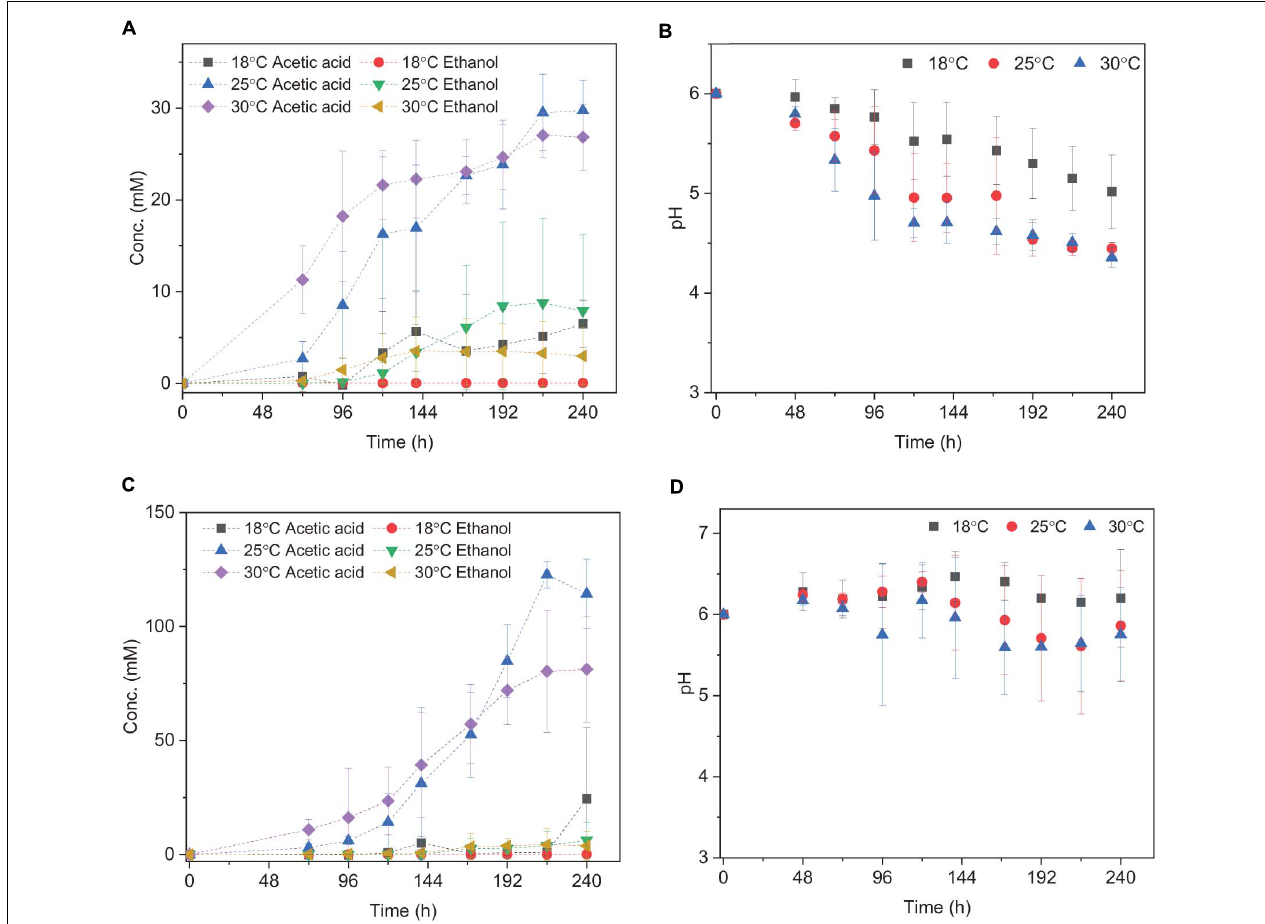
FIGURE 2 | Acetic acid and ethanol yield and pH change using (A,B) H 2 /CO 2 ; (C,D) H 2 /CO 2 + HCO 3 − by heat-treated granular sludge at 18, 25, and 30 ◦ C. Every point shown in the graphs is calculated as the average of three independent batch cultures, error bars indicate the standard deviation of the